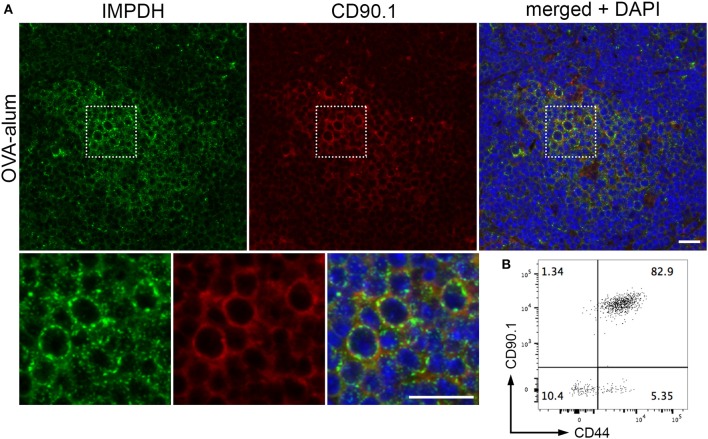
IMPDH forms filaments during in vivo antigen-specific T cell activation. (A) Representative images of OVA-specific adoptively transferred CD90.1+ (red) T cells with IMPDH (green) filaments in the spleen from a mouse immunized with OVA-alum. Areas marked by dotted squares are enlarged 3× and shown below to more clearly demonstrate IMPDH filaments in antigen-specific T cells. Counterstain: DAPI (blue). Scale bars: 20 μm. (B) Representative flow cytometry plot showing that a majority of adoptively transferred OVA-specific T cells (CD90.1+) are activated (CD44+) after immunization with OVA. Numbers indicate percentage of cells belonging to each quadrant.